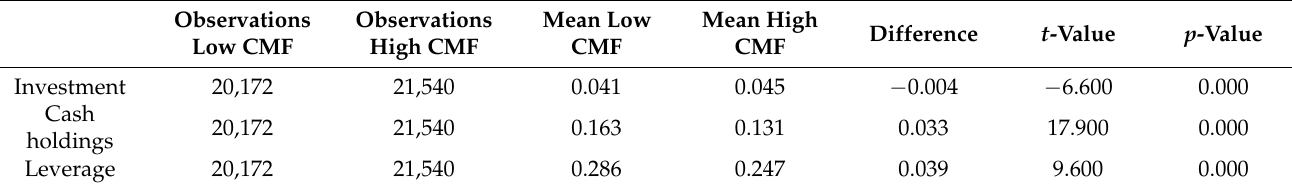
Table 5. Corporate Decisions under Credit Market Freedom